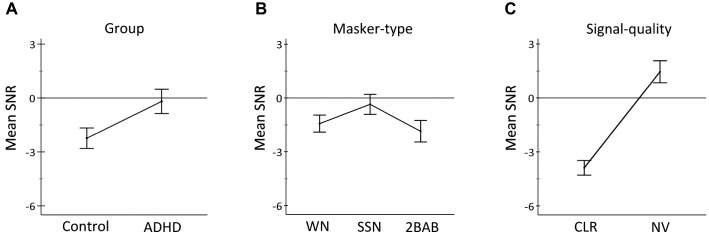
Graphs show significant main effects for (A) group (controls vs. ADHD), (B) masker type (WN: white noise; SSN: fluctuating speech-shaped noise; 2BAB: two-talker babble), and (C) signal-quality manipulation (CLR: clear vs. NV: noise-vocoded speech). Positive and negative estimated marginal means of SNRs resemble a reduction (<70 dB) and increase (>70 dB) in noise levels, respectively. Error bars represent 95% confidence intervals.